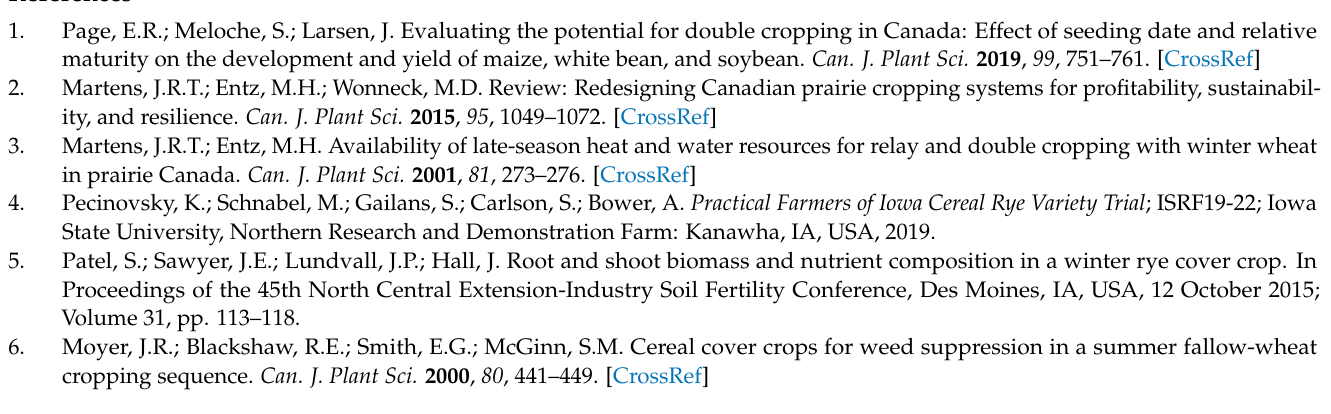
tion; Table S2: One-way ANOVA results of winter cereal nutrient composition; Table S3: One-way ANOVA results for dry matter yield, nutrient yield and uptake, and N use efficiency of barley and winter